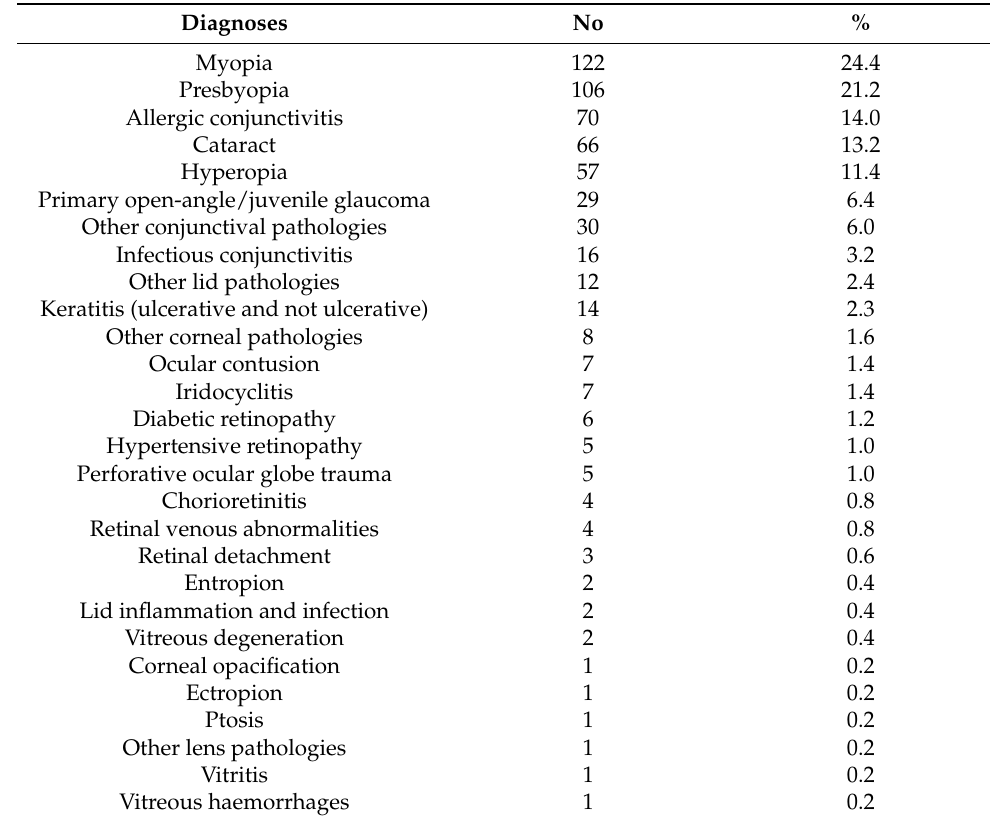
Table 2. Frequencies of ocular